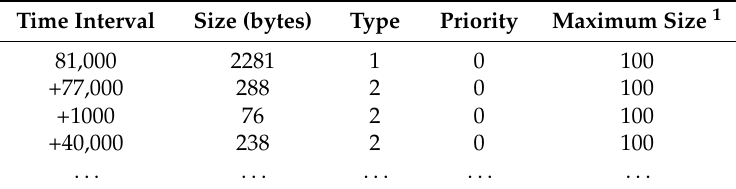
Table 4. Video1.frag file structure.